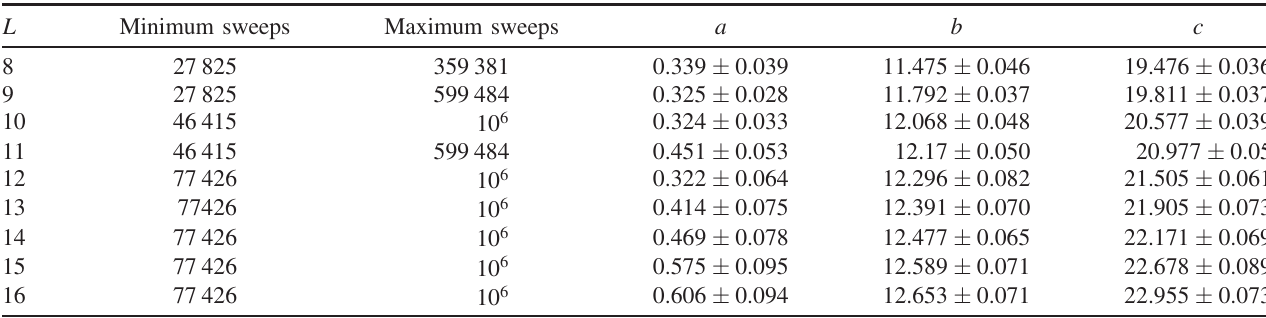
TABLE XIII. Fit to y ¼ a ð x − b Þ 2 þ c for the median results of the logical-planted instances using SQA with y ¼ log TTS and x ¼ log n . The factor c does not include f sweeps SQA